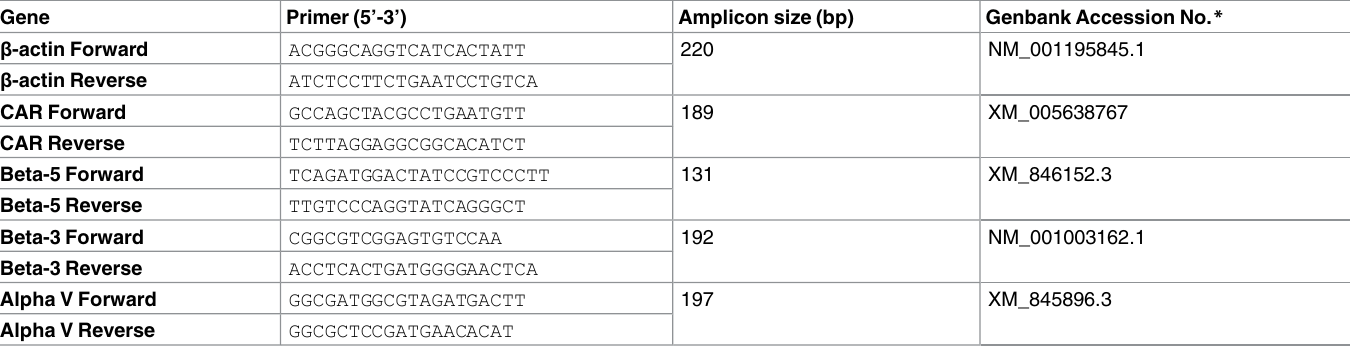
Table 1. Primers used for Quantitative reverse-transcriptase PCR.